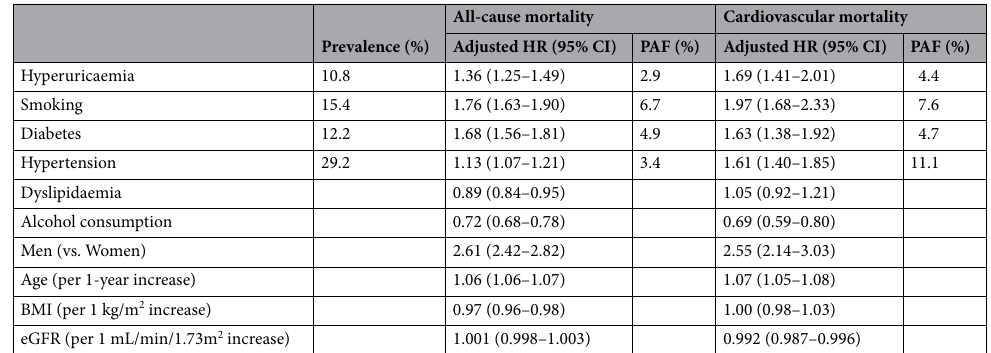
Table 2. Population attributable risk of hyperuricaemia for all-cause and cardiovascular mortality. HR hazard ratio, CI confidence interval, PAF population attributable risk fraction, BMI body mass index, eGFR estimated glomerular filtration